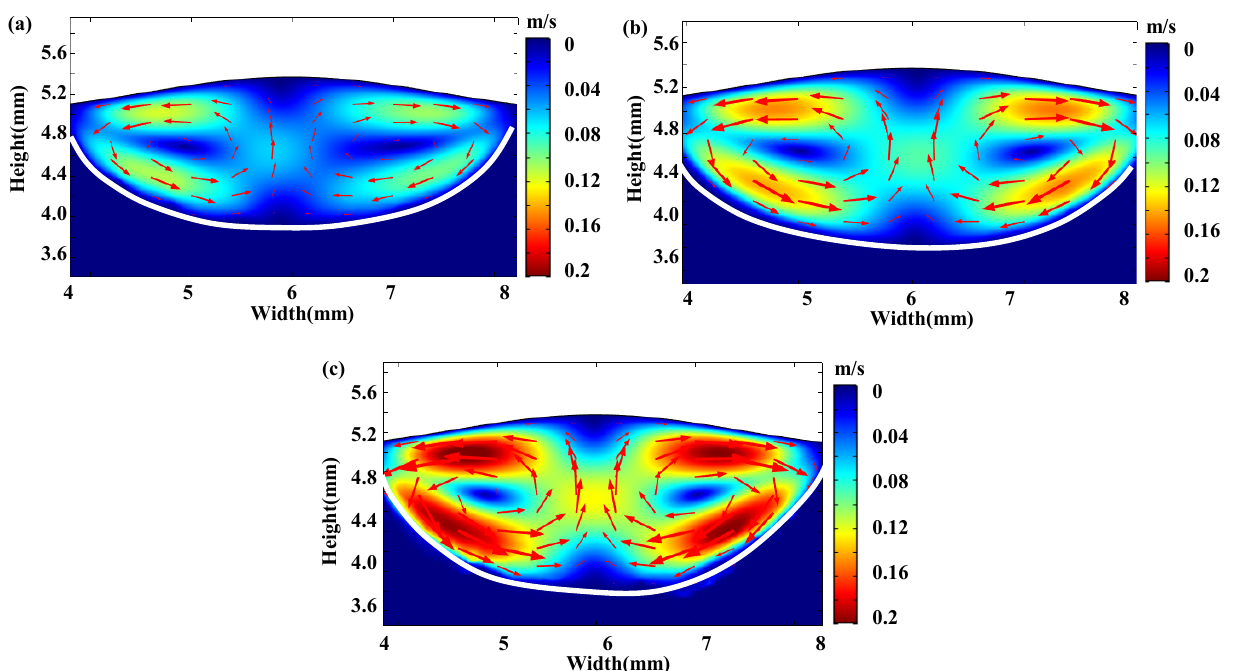
Figure 3. The flow field distribution of different vibration modes in the laser cladding melt pool at t = 0.45 s: ( a ) without vibration; ( b ) with 1D vibration; ( c ) with 2D vibration.